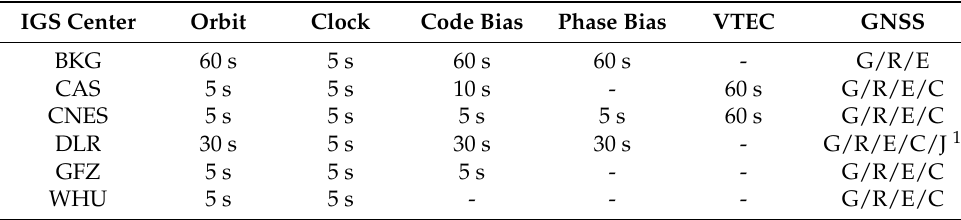
Table 1. The IGS SSR message information and the corresponding interval. IGS Center Orbit Clock Code Bias Phase Bias VTEC GNSS BKG 60 s 5 s 60 s 60 s - G/R/E CAS 5 s 5 s 10 s 60 s G/R/E/C CNES 5 s 5 s 5 s 5 s 60 s G/R/E/C DLR 30 s 5 s 30 s 30 s - G/R/E/C/J 1 GFZ 5 s 5 s 5 s - - G/R/E/C -